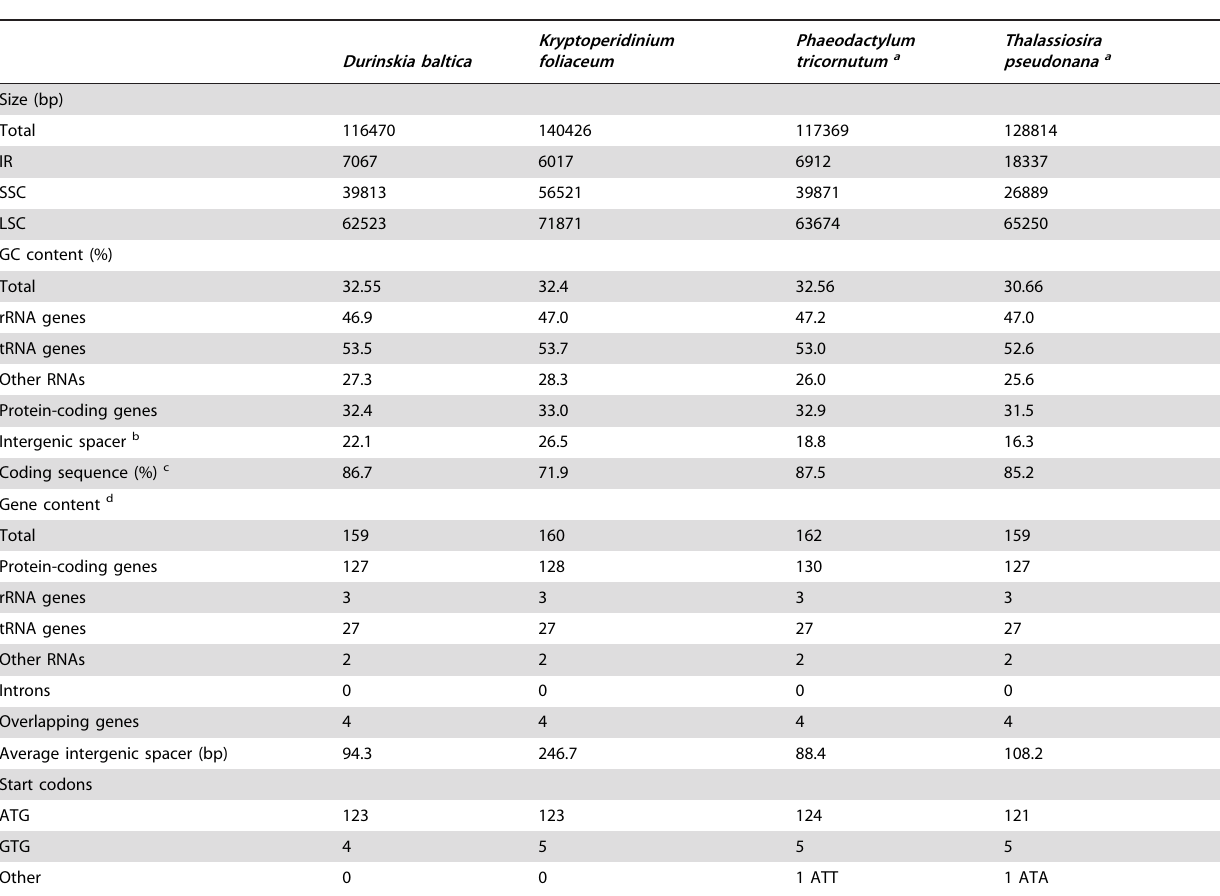
Table 1. General characteristics of plastid genomes in dinotoms compared to diatoms.